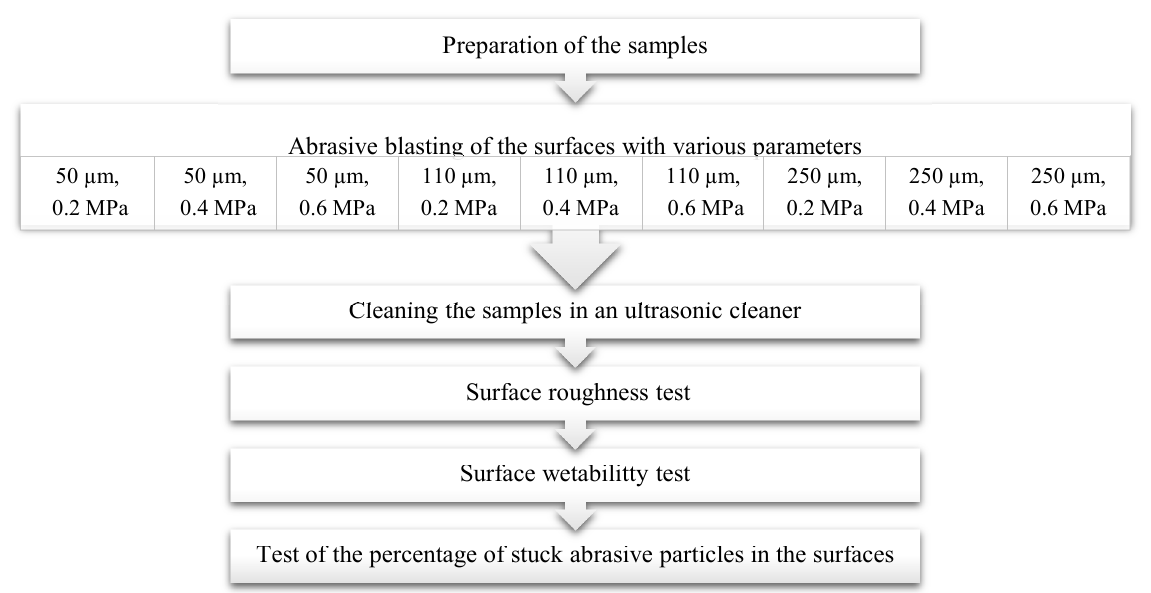
Figure 1. Photograph of the Ni-Cr alloy surface after SiC blasting cleaning size 50 µm, pressure 0.2 MPa: ( a ) the image before the processing in the program; ( b ) the image after it.